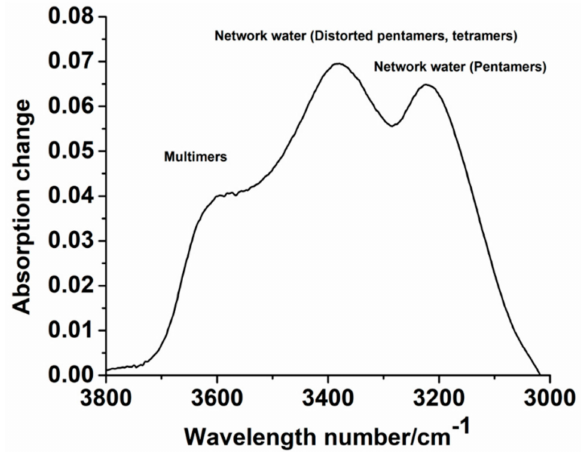
Figure 7. Representative subtracted FTIR spectrum. The peaks located at ~3225, 3400, and 3600 cm − 1 are used to determine the R network / R multimer . Spectra for all phytoglycogen extracts can be found in Supplementary Figure S1.